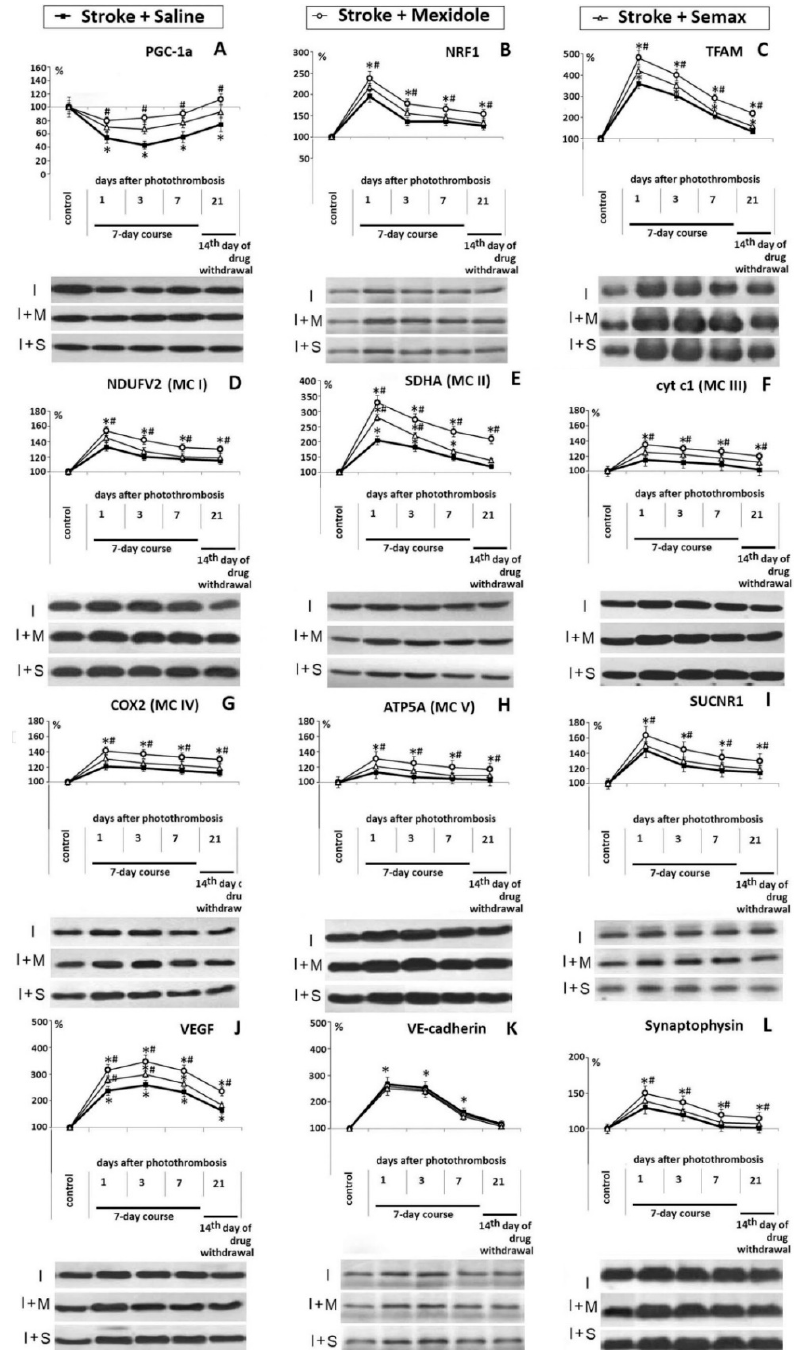
Figure 6. Influence of a 7-day course of Mexidol and Semax treatment on PGC-1 α expression and the levels of protein markers of PGC-1 α activity in the penumbral zone for 21 days after ischemia. The diagrams represent the results of a densitometry analysis, expressed in percentages, of the corresponding protein bands on the Western blot images. Representative immunoblots of PGC-1 α ( A ), NRF1 ( B ), TFAM ( C ), NDUFV2 ( D ), SDHA ( E ), cyt c1 ( F ), COX2 ( G ), ATP5A ( H ), SUCNR1 ( I ), VEGF ( J ), VE-cadherin ( K ), and Synaptophysin ( L ) target proteins are included in the figure. The number of animals used for Western blot densitometry was n = 3 per each experimental episode. * p < 0.01 denotes a significant difference from the Control group; # p < 0.01 denotes a significant difference from the Stroke + Saline group; statistical analysis: A two-way ANOVA with Bonferroni’s post-hoc multiple comparison test. I (Ischemia): Stroke + Saline group; I + M: Stroke + Mexidol group; I + S: Stroke + Semax group.